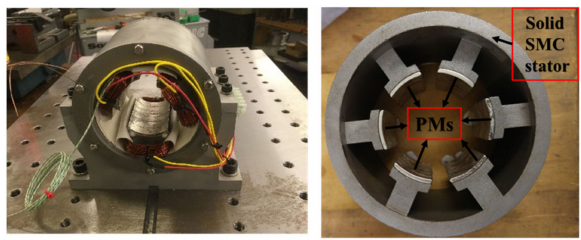
Figure 7. Laboratory prototypes of cylindrical